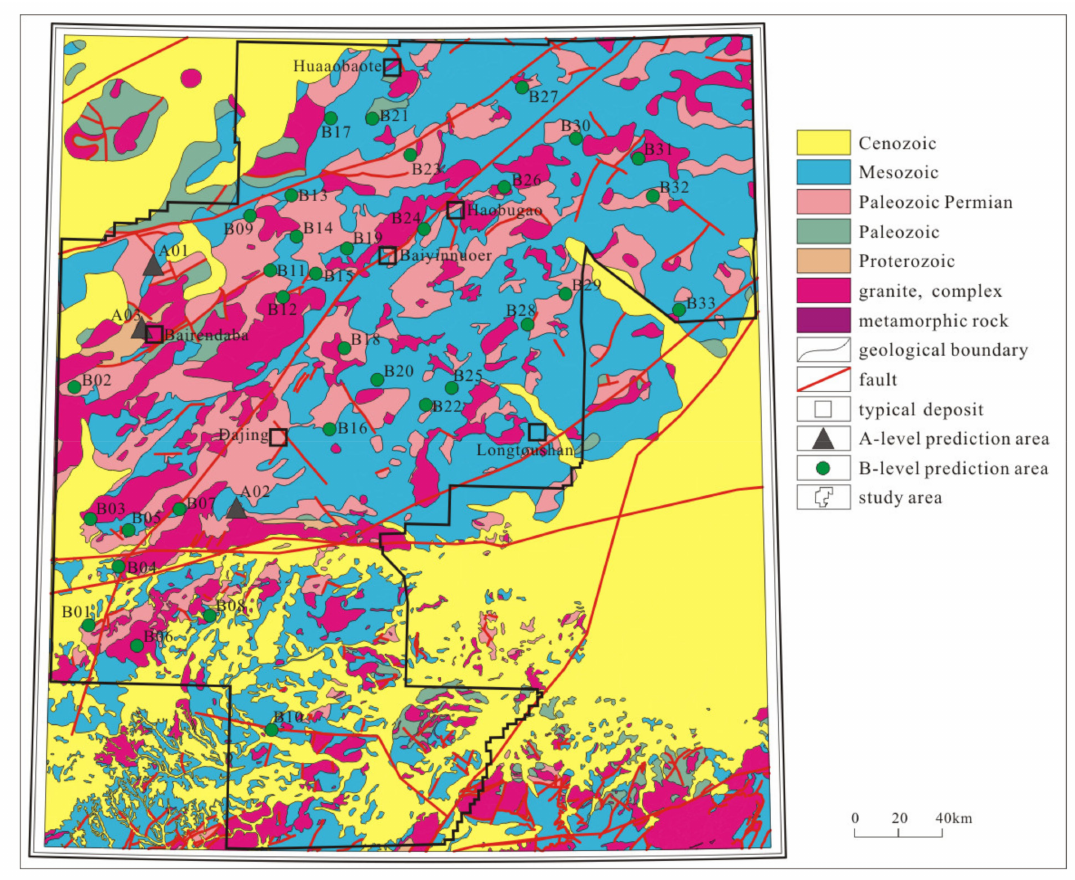
Figure 4. Distribution diagram of the metallogenic prediction